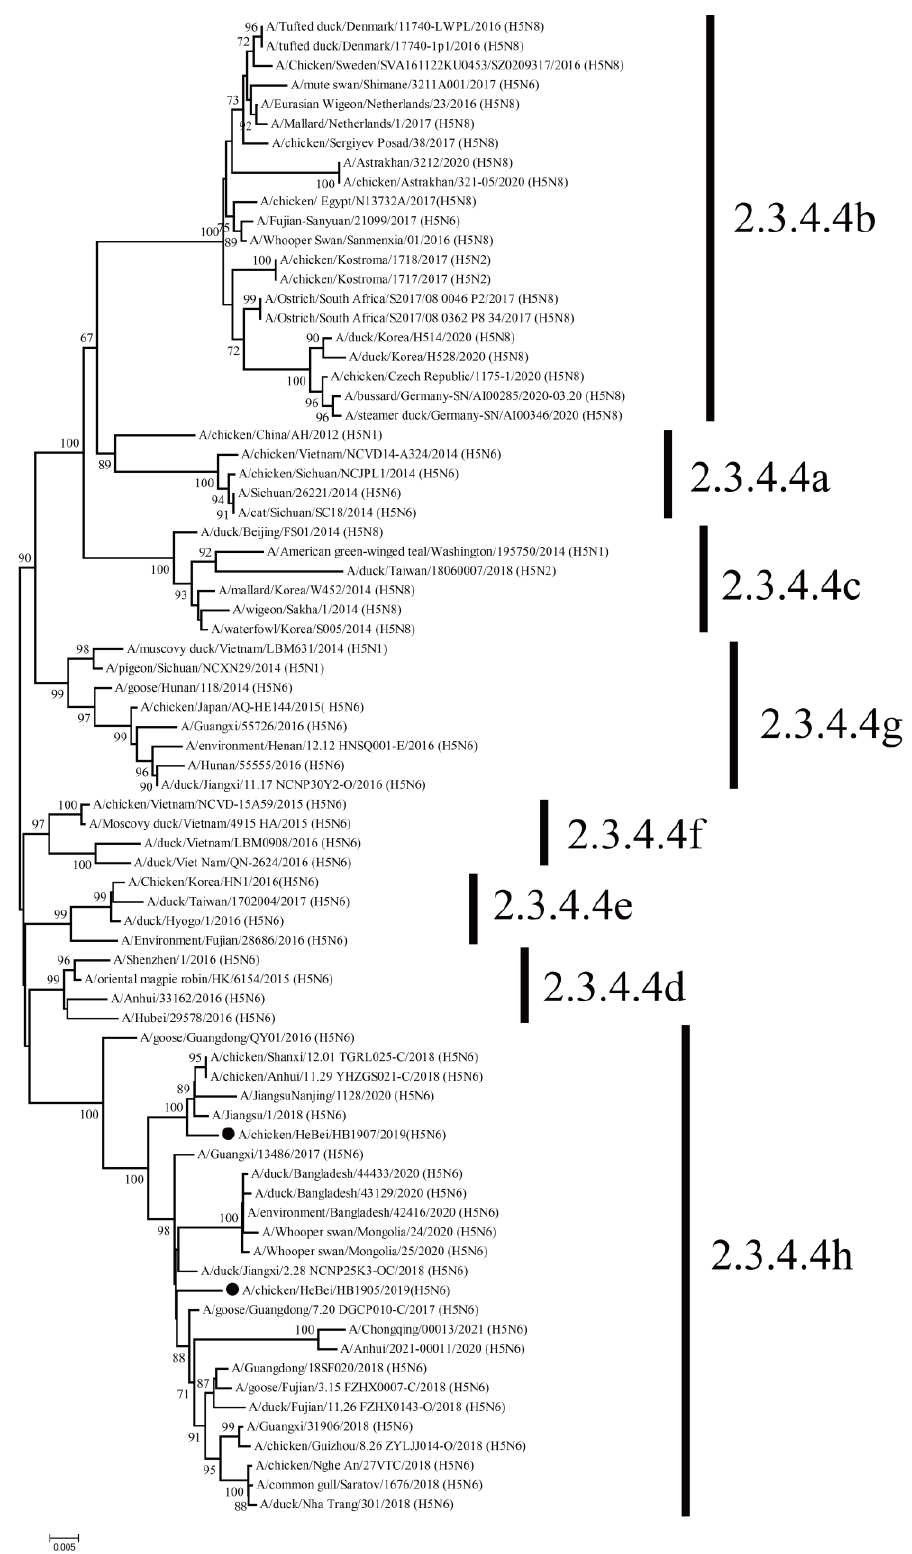
Figure 1. Phylogenetic tree of the HA genes of the H5N6 (HB1905 and HB1907) viruses. The tree was constructed by using MEGA 7.0.21 software using the maximum likelihood (ML) with a bootstrap value of 1000. Sequences in this study are marked with black circles.